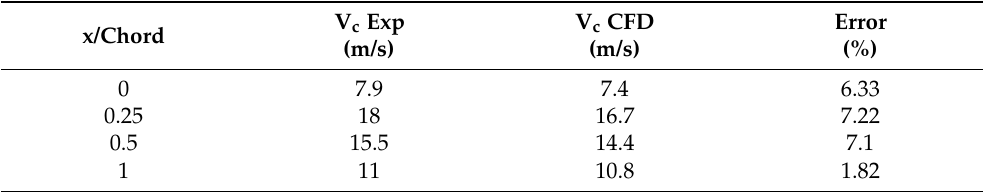
Table 3. Experimental wind tunnel vs. CFD velocity data for the NACA 2424 augmentation